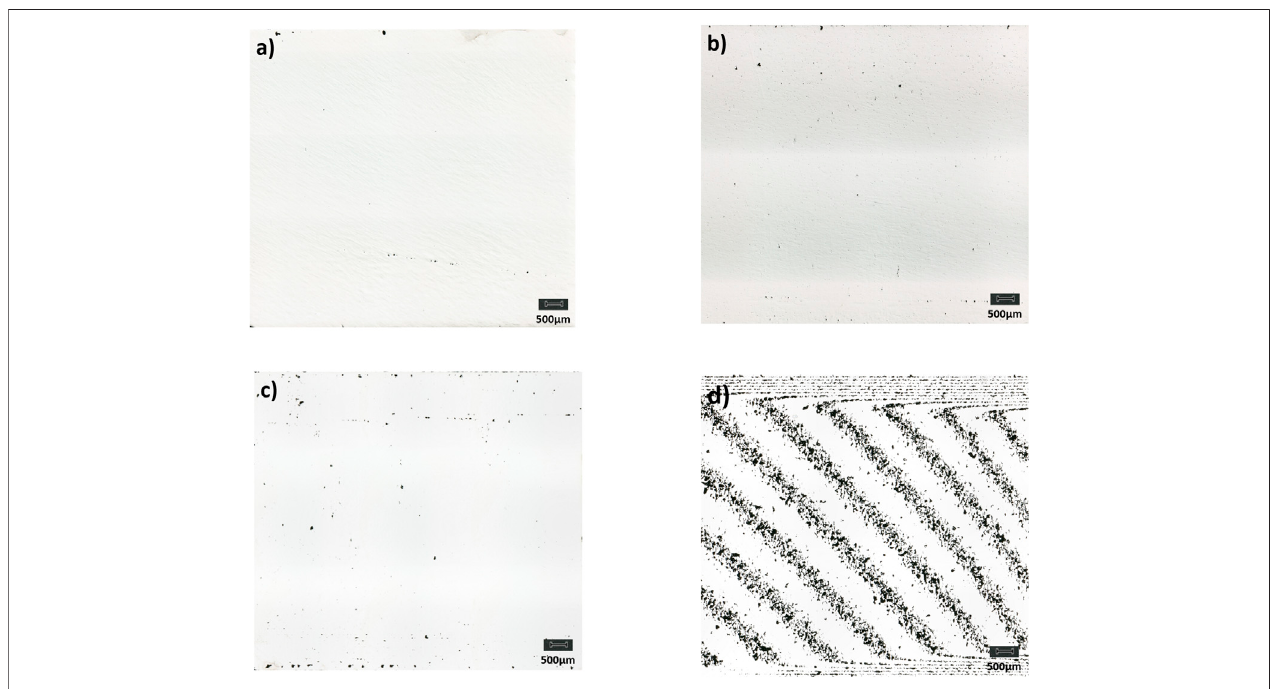
FIGURE3| Micrographsforopticalrelativedensity measurementsfordifferentdensitycubes (A) ρ =99.95%, k =5.62 W/mK (B) ρ =99.90%, k =4.20 W/mK, (C) ρ = 97.40%, k = 3.33 W/mK, (D) ρ = 90.24%, k = 4.93 W/mK.